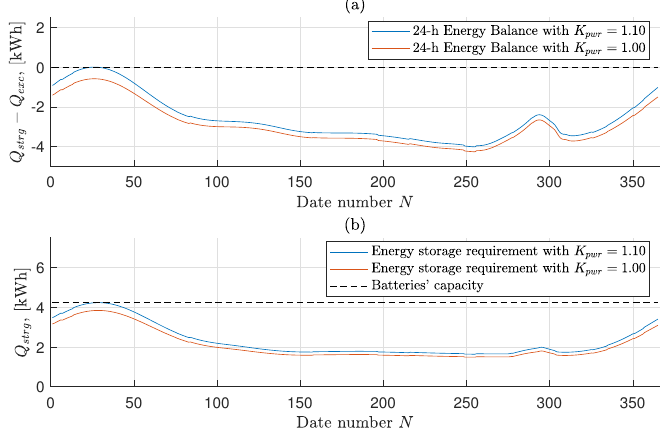
Figure 9. Energy balance evaluation ( a ) and energy storage requirement ( b ) for operation throughout the year at 20 km altitude above Pontianak,